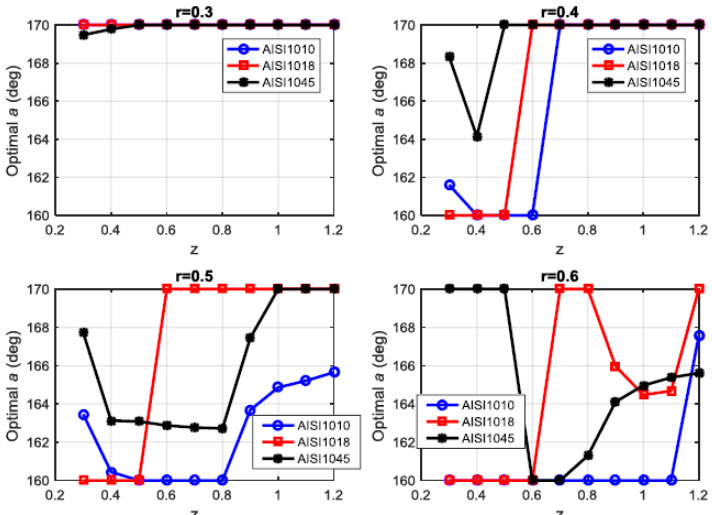
Figure 12. Comparison of optimal values of punch face angle ( a ) for different steels.